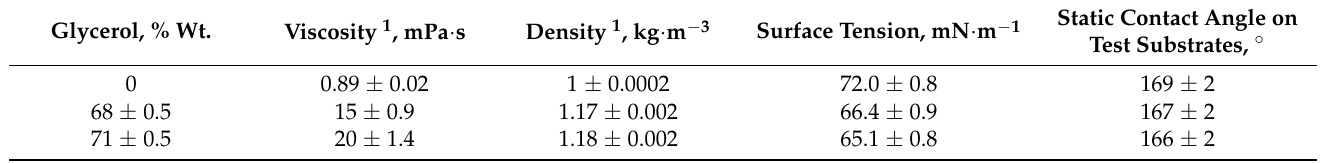
Table 1. Properties of experimental fluids (water and aqueous glycerol solutions) at 25 ◦ C. Glycerol, %